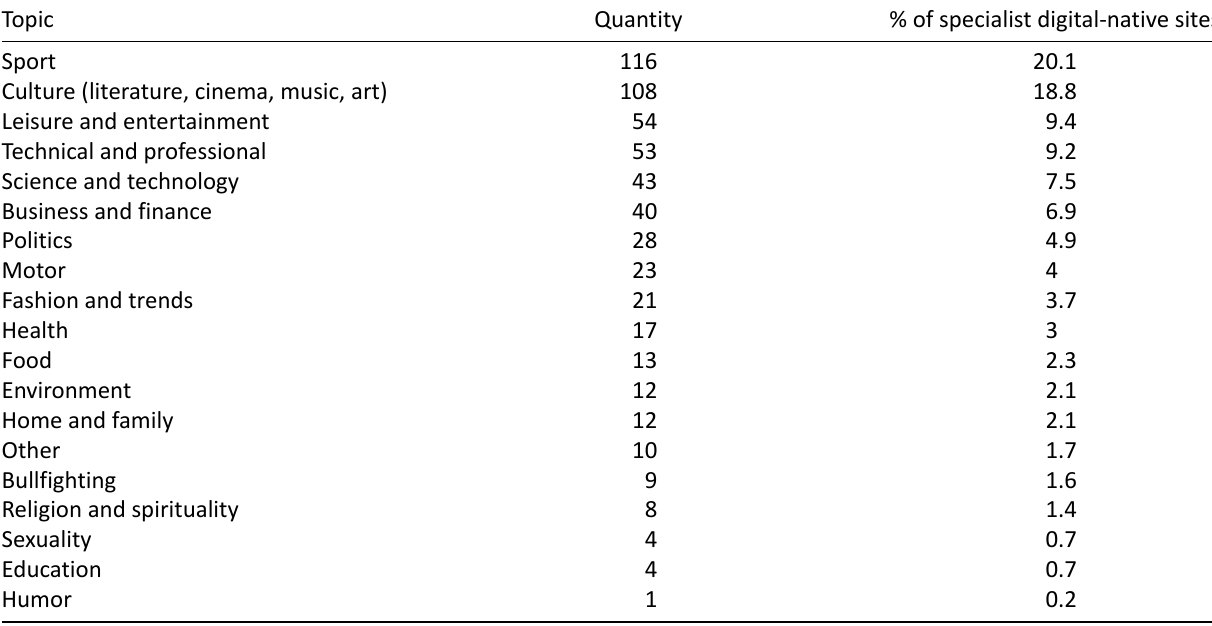
Table 5. Main topic focus of active specialized digital-native news media (N = 576, November 2019).